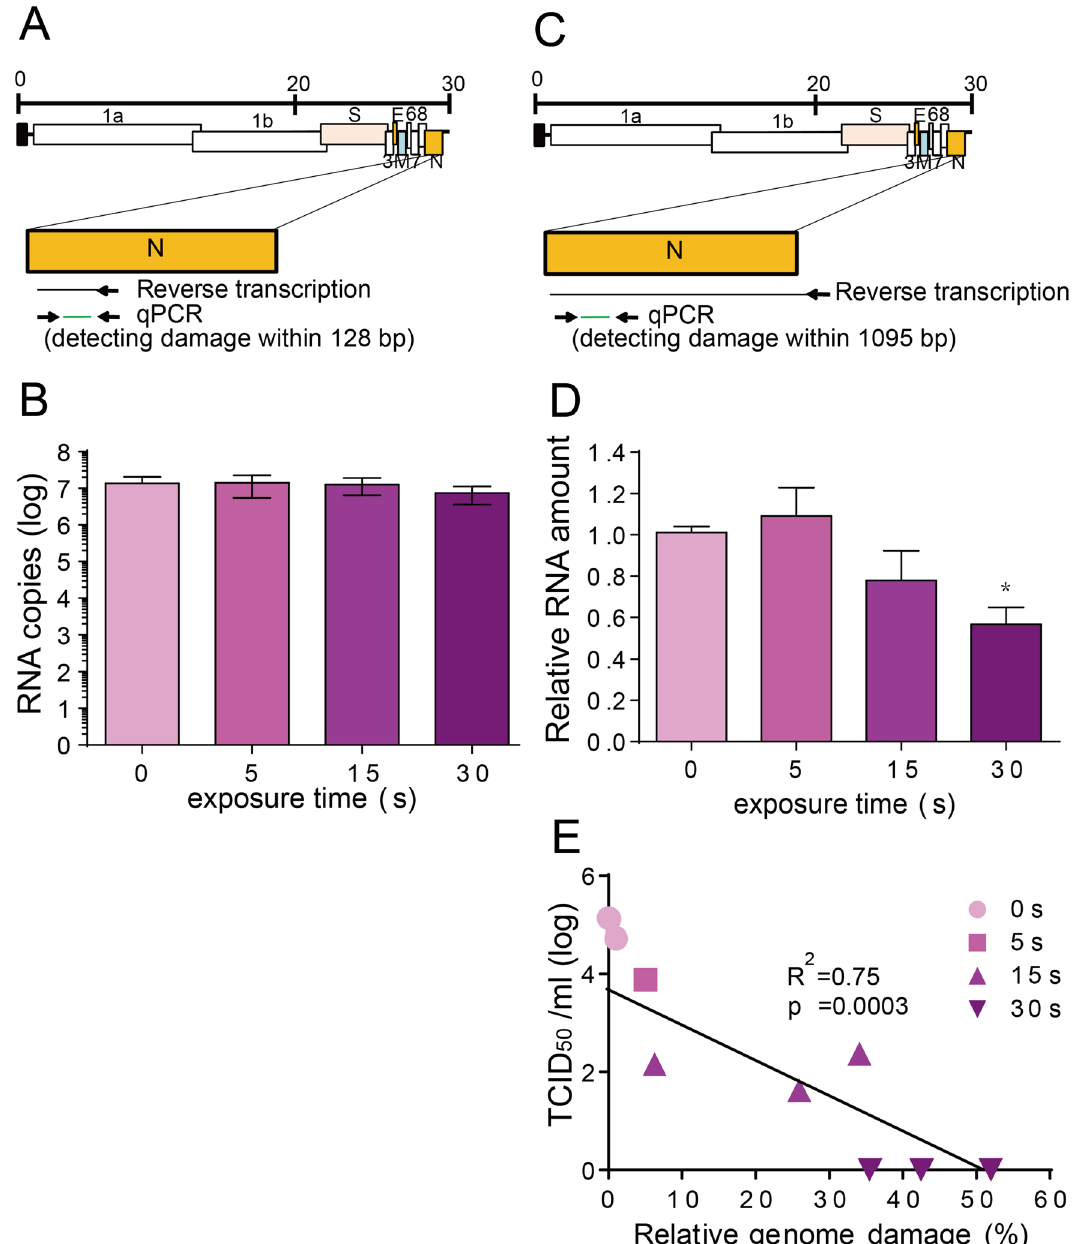
Figure 4. Reverse-transcription quantitative-polymerase chain reaction (RT-qPCR) to determine the effect of ultraviolet C (UVC) irradiation on the viral genome. ( A ) Schematic diagram of the conventional RT-qPCR RT-priming site and qPCR primer sites. ( B ) Quantitative results of conventional RT-qPCR. SARS-CoV-2 (5 mL) with a titer of 5 × 10 4 50% tissue culture infective dose (TCID 50 /mL) was irradiated with a UVC light tube for increasing periods of time from 0 to 30 s; the viral RNA was extracted and then viral RNA copy number was determined. ( C) Schematic diagram of the long RT-qPCR RT-priming site and qPCR primer sites. ( D ) Quantitative results of long RT-qPCR. SARS-CoV-2 (5 mL) with a titer of 5 × 10 4 TCID 50 /mL was irradiated with a UVC light tube for increasing periods of time from 0 to 30 s. The relative RNA fold change compared to 0 s irradiation is calculated. Data in the plot represent the mean ± standard deviation (SD) of three replicates. Significance has been determined using one-way analysis of variance followed by Dunnett’s multiple comparisons test. The asterisk indicates a statistical difference (* p < 0.05). ( E ) Linear regression analysis between relative viral genome damage and virus infectivity (derived from Fig. 2A) based on the long-RT-qPCR results. Relative genome damage is calculated as follows: (1-relative RNA fold change compared to control) × 100%. The data points that outside the axis limits are not shown in the